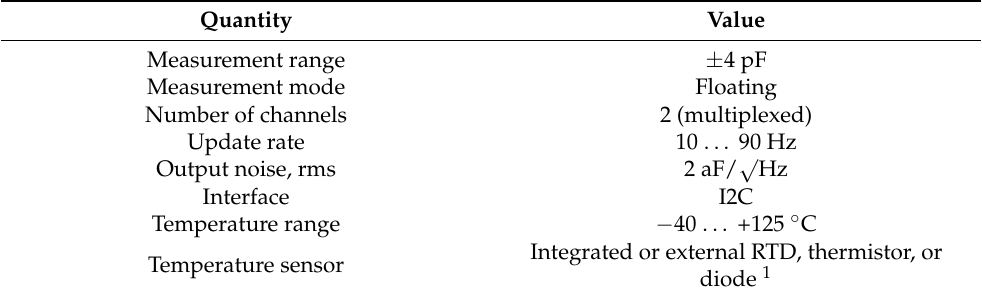
Figure 14. Electrical diagram of the sensors PCB1 and PCB2. The MID sensor only uses channel 1. Table 2. AD7746 specifications; Data extracted from [56].